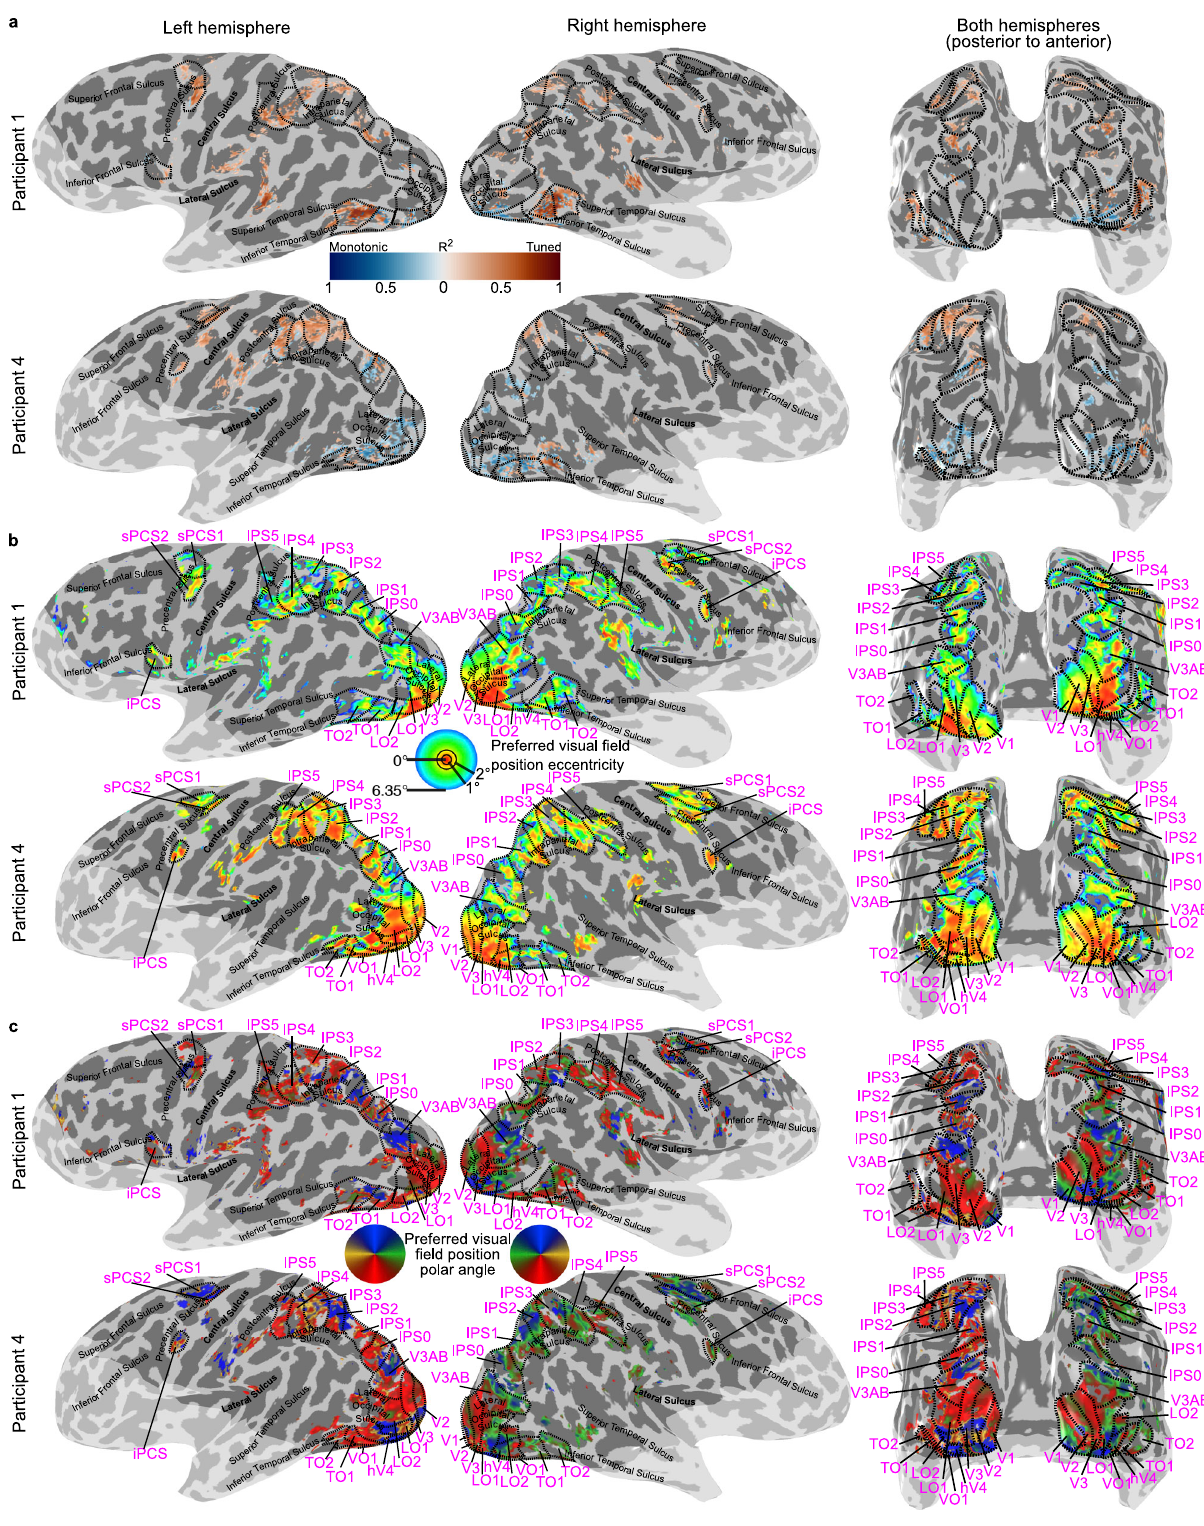
Fig. 2 Progressions of best-performing model on timing-selective responses and visual fi eld position preferences. a Cross-validated variance explained of the best-performing model within each voxel is displayed (averaged across both cross-validation splits, for voxels with a variance explained above 0.2 for the best fi tting model). The variance explained of the monotonic response model is given in blue and of the tuned response model is given in red. The intensity of the color relates to the magnitude of the variance explained. b Eccentricity preferences for voxels with over 0.1 variance explained by the response model. c Polar angle preferences for voxels with over 0.1 variance explained by the response model. Visual fi eld map borders are shown as black dashed lines, and named in magenta text. The light shaded region is outside the fMRI recording volume. See also Supplementary Figs. 3 – 5. Images in b and c adapted from Harvey et al., 2020 19